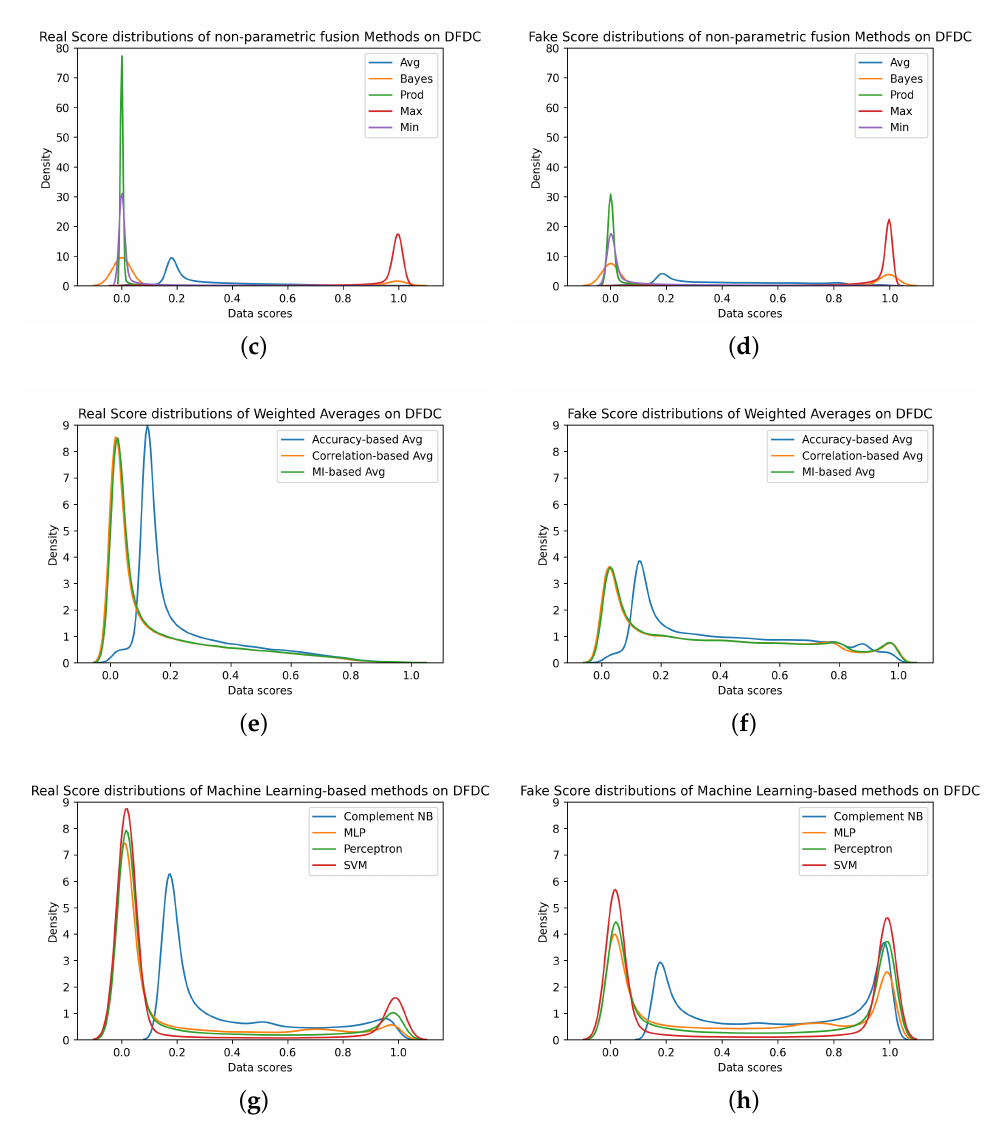
Figure 7. Score distributions related to the DFDC dataset from single methods ( a , b ), non-parametric fusion methods ( c , d ), weighted averages ( e , f ), and Machine Learning-based methods ( g , h